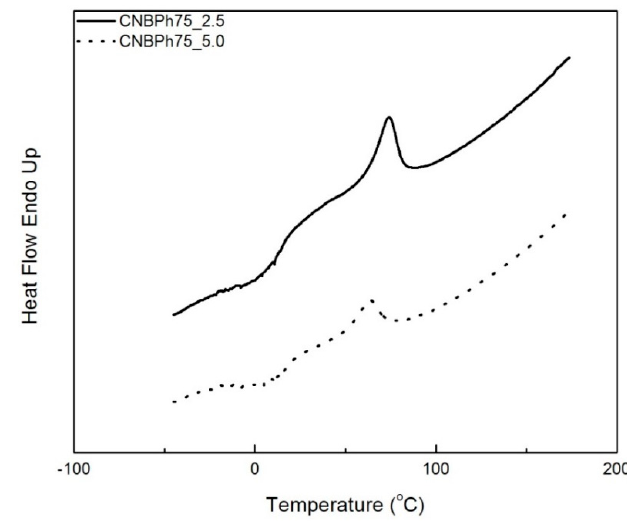
Figure 3. DSC heating curves for the CNBPh75_2.5 and CNBPh75_5.0 membranes.